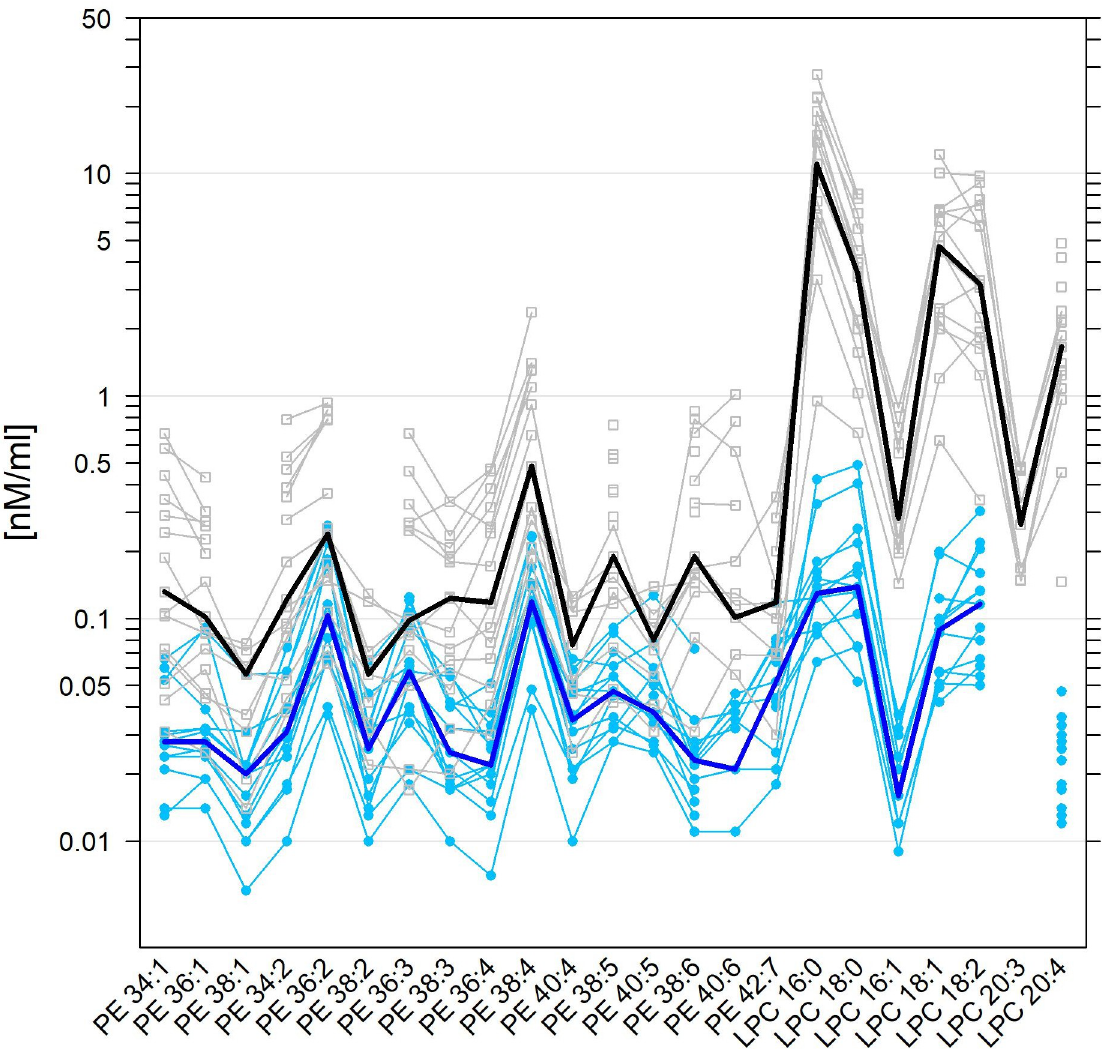
Fig 3. Superposed parallel plots for normal human and equine SF levels of PE and LPC species. For further details, see the caption of Fig 2, which is fully analogous, but here for PE and LPC species.